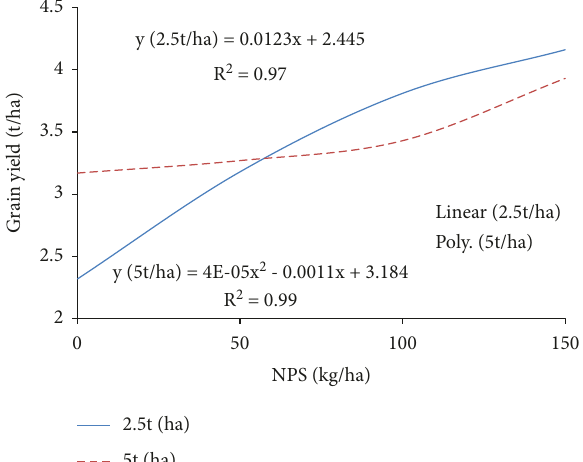
Figure 3: Grain yield of the common bean as affected by inter- action effects of NPS and LL rates.